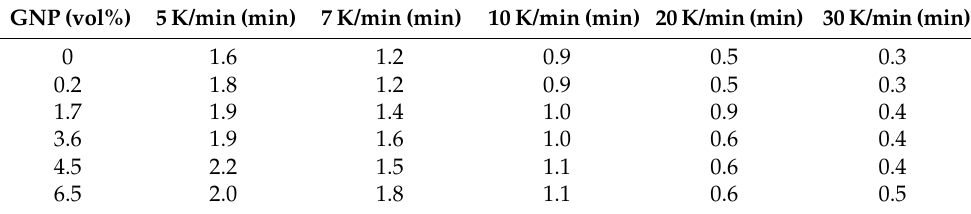
Table 6. Half times t 1/2 of the EVA20/GNP composites’ crystallisation process at different tempera- ture gradients. The pure EVA20 noted as 0 vol% is displayed for comparison.